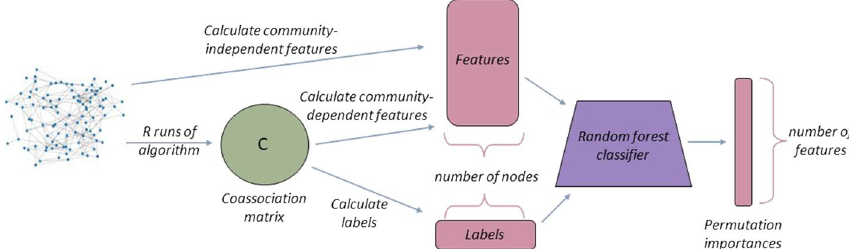
Fig. 1 Experiments for determining explainable social network analysis metrics in the node feature experiment. A similar methodology is applied to the node-pair experiment. After R runs of the algorithm, a coassociation matrix is constructed encoding how often two nodes are classified in the same community. Feature values are computed and provided as input to a random forest classifier to determine permutation importance. The distributions of permutation importance can be compared across all graphs to identify explainable